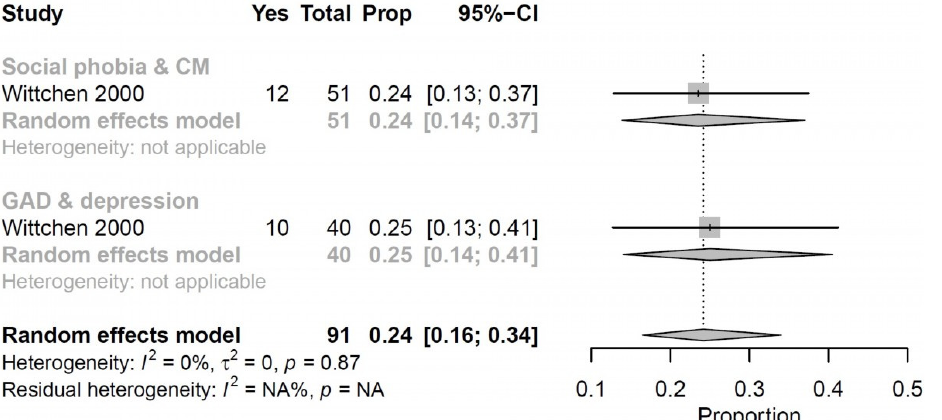
Figure 2. Forest plot shows the percentage of middle-aged persons with multimorbidity and paid employment. When retired populations were identified, they were excluded.